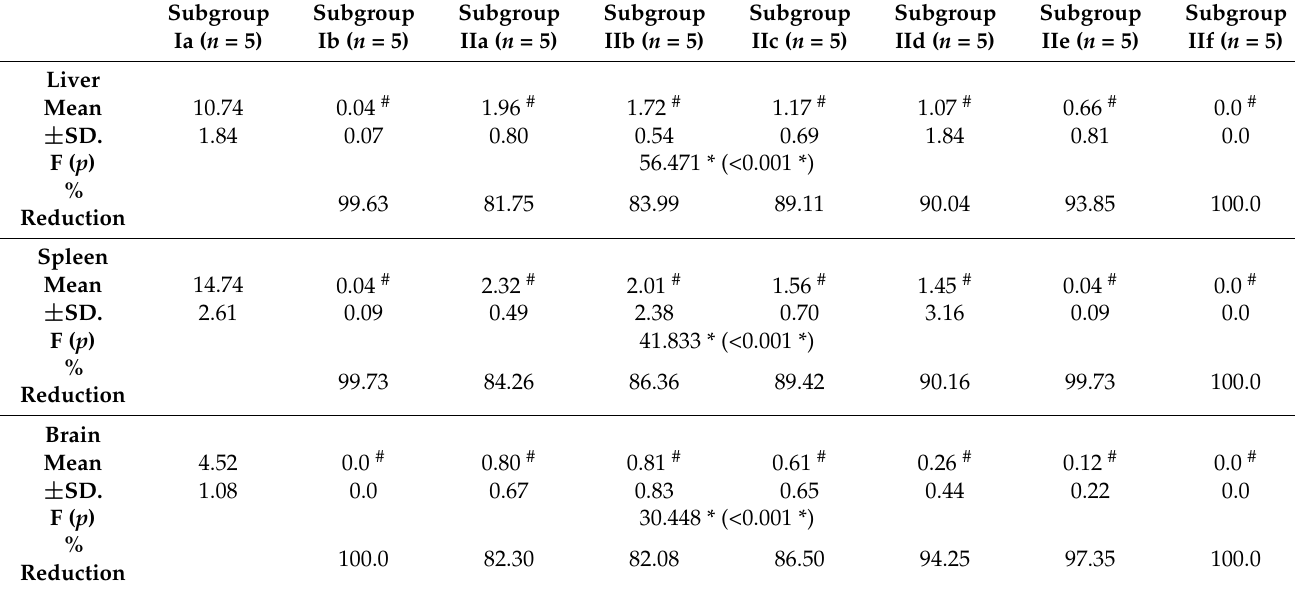
Table 4. Mean tachyzoites count and percent reduction in the liver, spleen and brain of the different studied